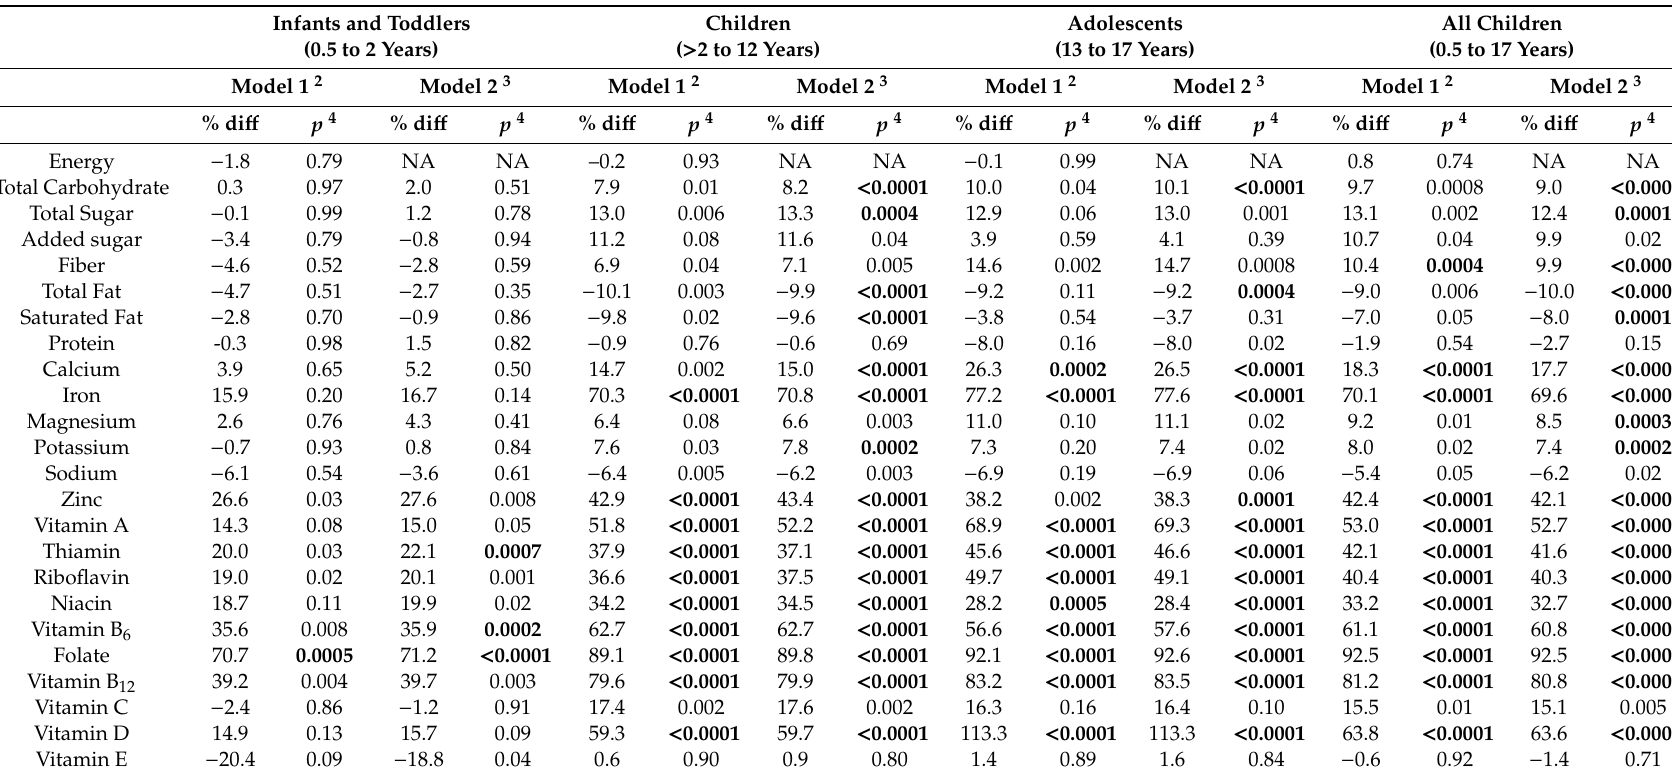
Table 2. Percentage di ff erence between ready-to-eat (RTE) cereal eaters and RTE cereal non-eaters in nutrient intakes, National Health and Nutrition Examination Survey 2015–2016 1